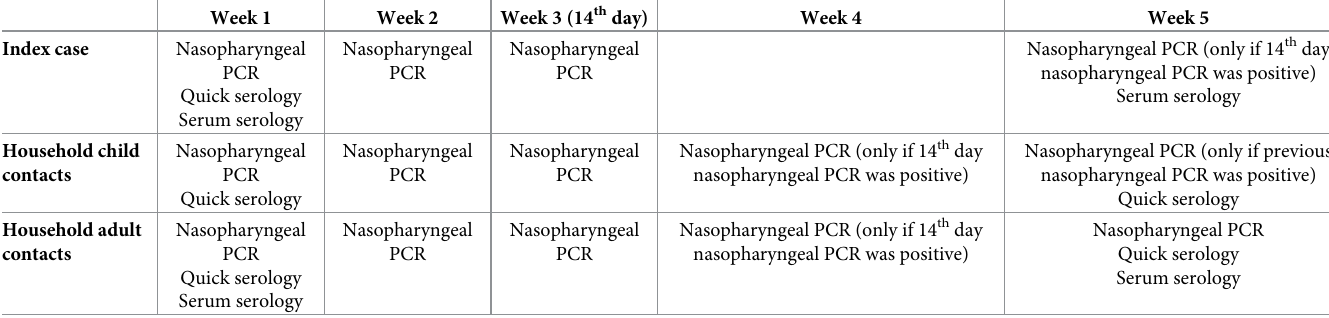
Table 1. Sequence of laboratory specimen collection, tests, and follow-up visits after the diagnosis of the index